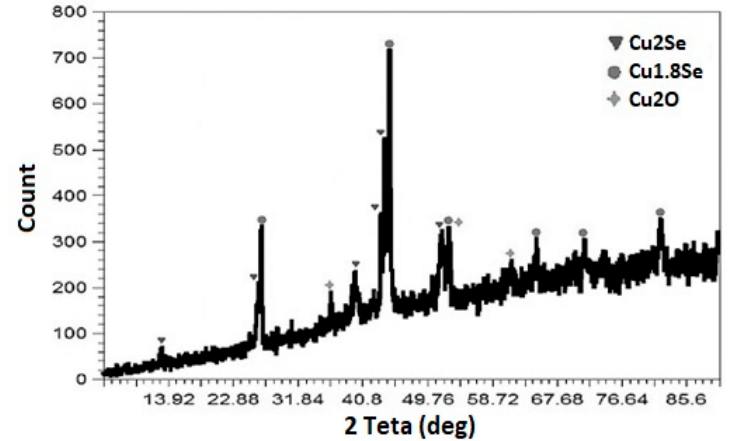
Figure 7. XRD pattern of sediments for dual cementation of Se and Te at 4000 mg/L Se, 1000 g/L Te, 75 g/L H 2 SO 4 and 15 g/L CuSO 4 and 35 °C.